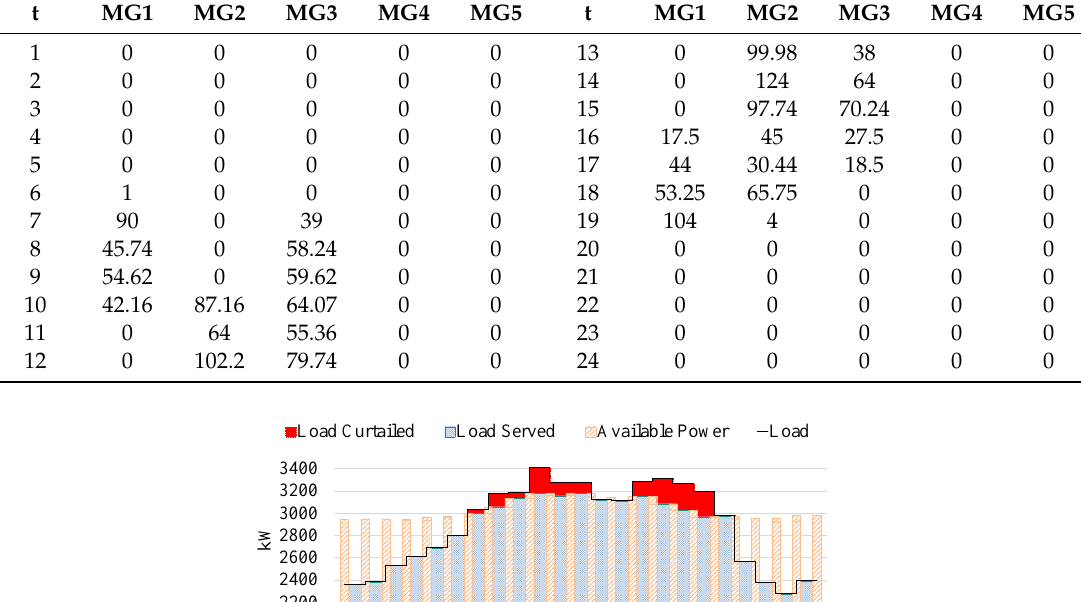
Table 6. Optimal power allocated to each microgrid in kW.